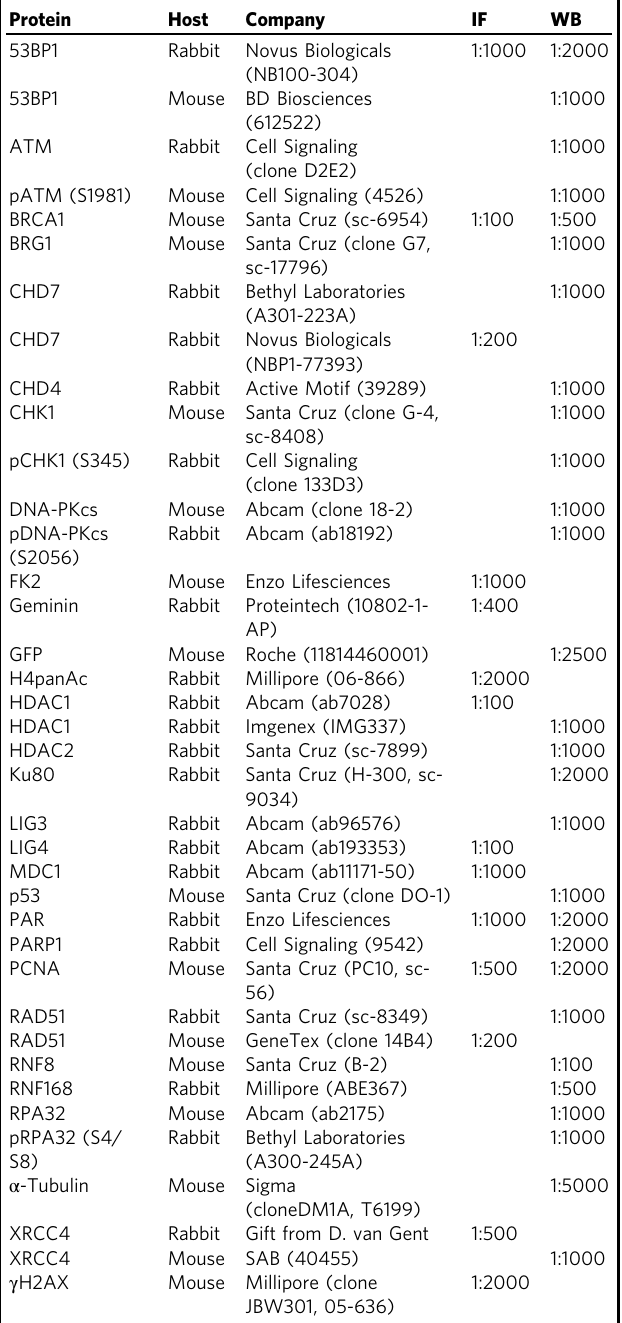
Table 3 List of primary